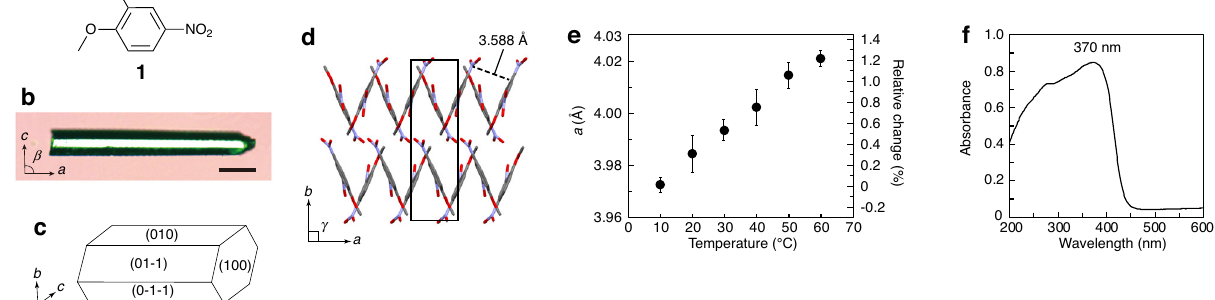
Fig. 1 | Physical properties of the 1 β single crystal. a Chemical structure of 2,4- dinitroanisole ( 1 ). b A photo of a 1 β single crystal under crossed Nicols. The scale baris100 μ m. c Faceindicesoftherod-shapedcrystal. d Moleculararrangementon the(001)plane.Disorderedoxygenatomsoftwonitrosubstituentsareomittedfor